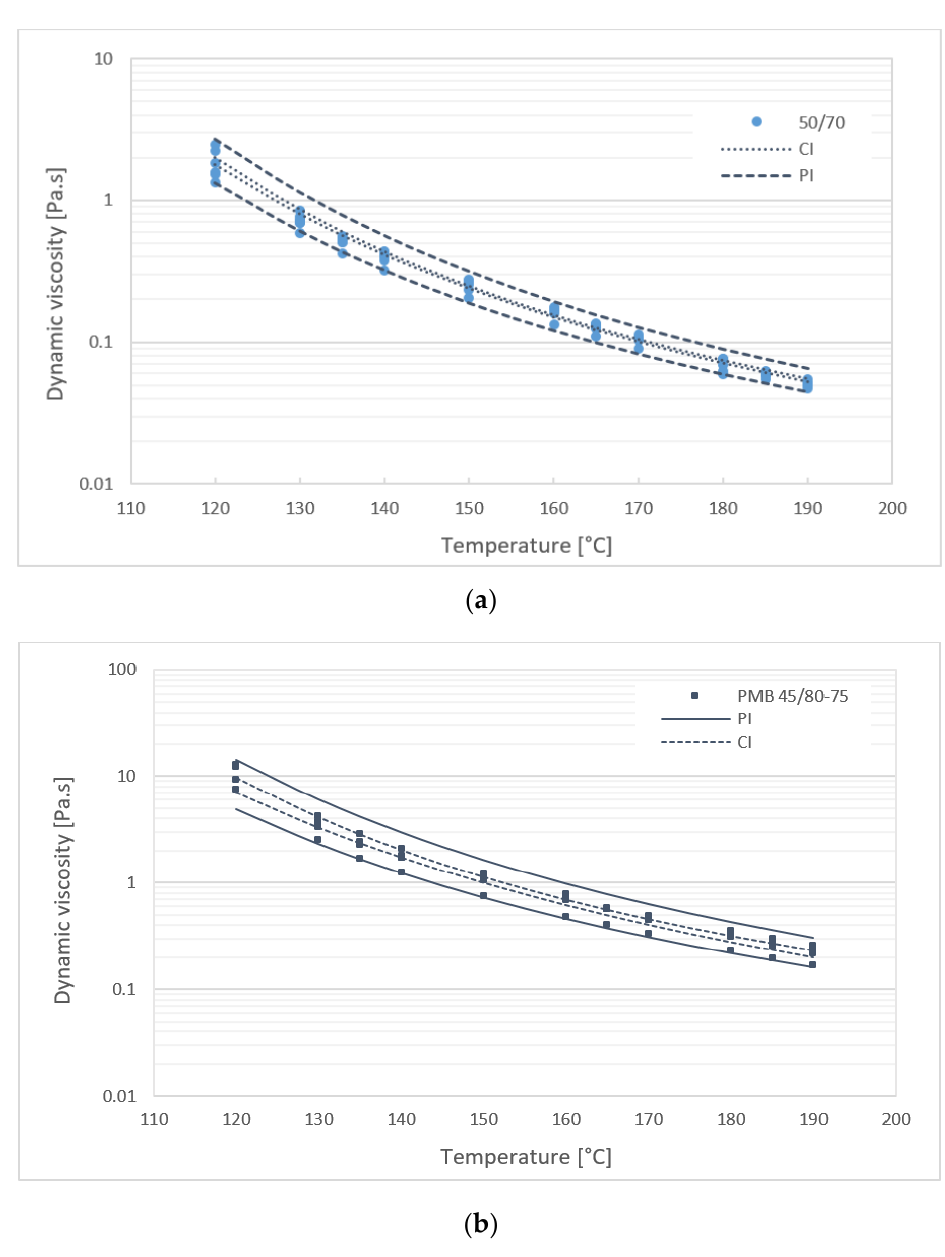
Figure 7. Dynamic viscosities of ( a ) 50/70 bitumen samples and ( b ) PMB 45/80-75 samples with confidence intervals. Table 2. Analysis of variance for dynamic viscosity of the tested bitumen binders, α = 0.05, the effect of